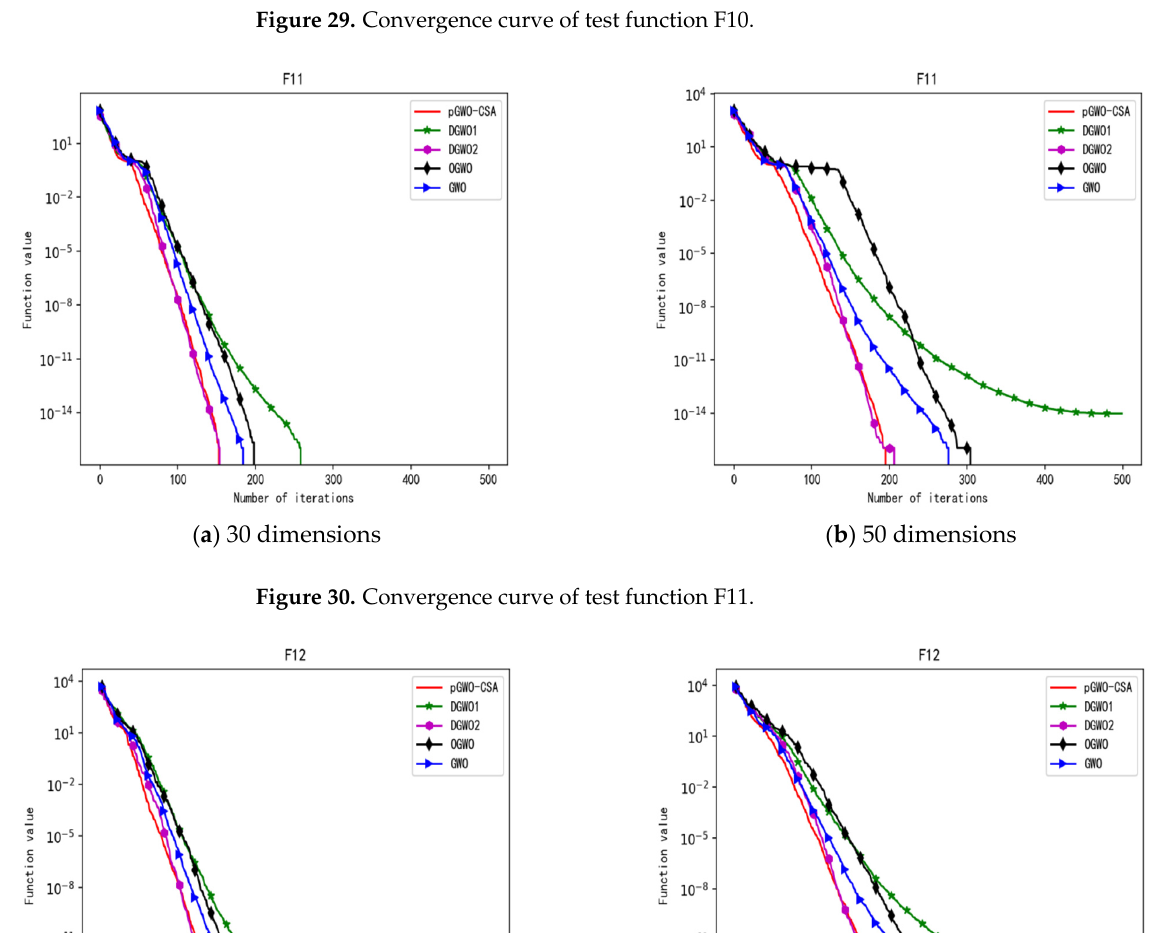
Figure 29. Convergence curve of test function F10.